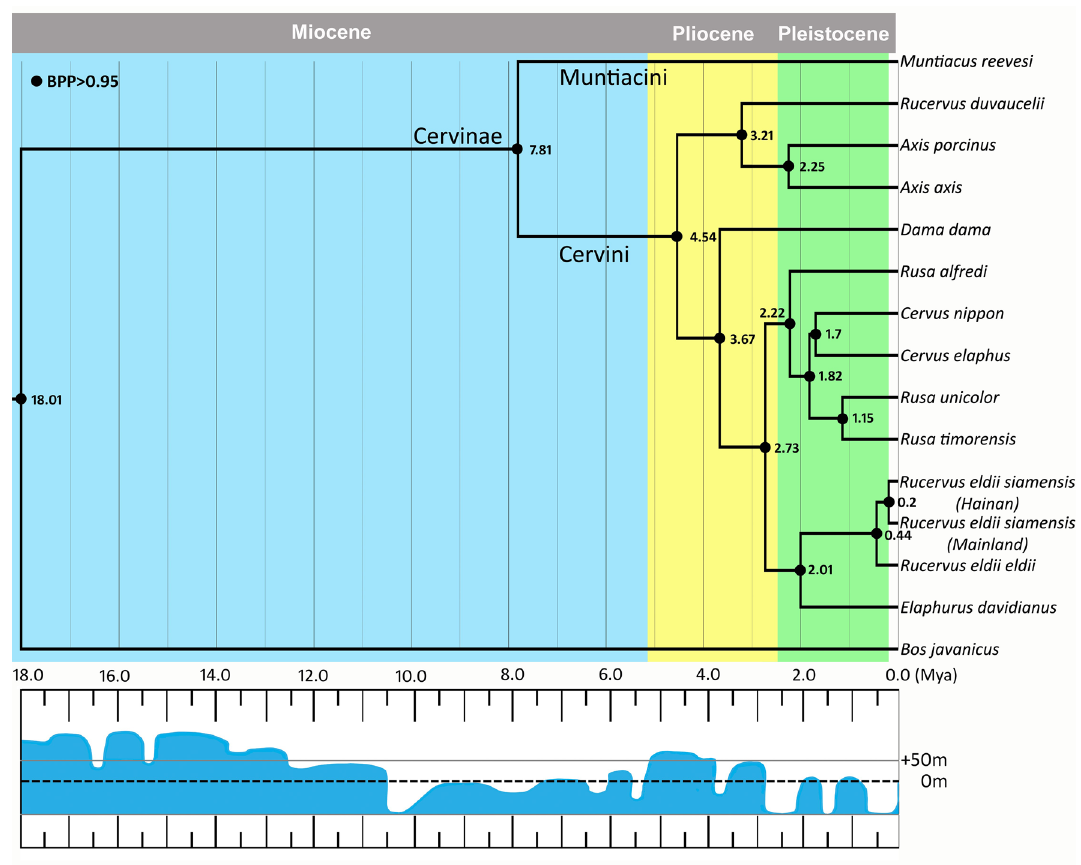
are presented under the chronogram 35 . The current sea levels are represented by the dashed line (0 m). The geological time scale was acquired from the Geological Society of